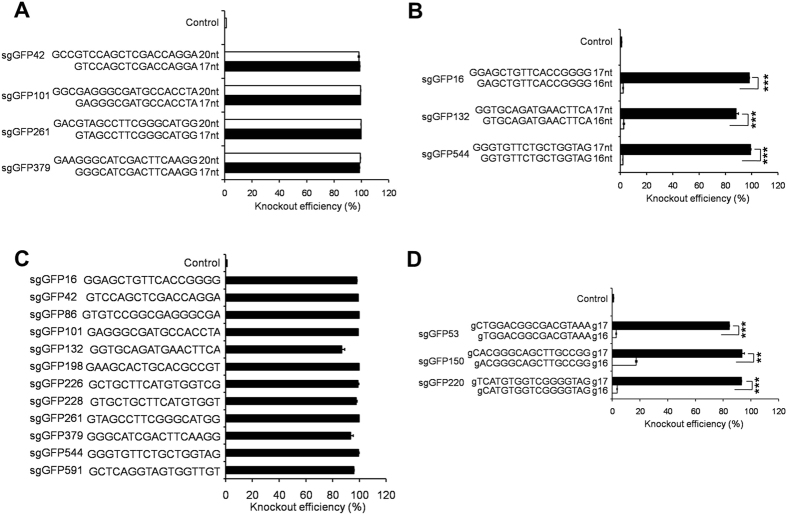
Targeting activities of full-length sgGFPs and truncated sgGFPs in 293T cells.(A) Comparison of GFP knockout efficiency of 17nt vs. 20nt sgGFPs in 293T GFP-reporter cells. Four pairs of sgGFPs were designed to target GFP sites 42, 101, 261 and 379. Lengths and sequences of the sgRNAs are shown. Cells transduced with a scrambled sgRNA served as a control. Data shown are mean ± SEM (n = 3). (B) Comparison of GFP knockout efficiency of 17nt vs. 16nt sgGFPs in 293T GFP-reporter cells. Three pairs of sgGFPs were designed to target GFP sites16, 132, and 544. Lengths and sequences of the sgRNAs are shown. Data shown are mean ± SEM (n = 3). ***P < 0.001. (C) GFP knockout efficiency in 293T GFP-reporter cells with 17nt sgRNAs. Twelve sgGFPs were designed to target different locus of the GFP gene. Data shown are mean ± SEM (n = 3). (D) Comparison of GFP knockout efficiency of gN16 vs. gN17 sgGFPs in 293T GFP-reporter cells. Three pairs of gN16 and gN17 sgGFPs were designed to target GFP sites 53, 150, and 220. Little g indicates mismatched guanine (G). Sequences of the sgRNAs are shown. Data shown are mean ± SEM (n = 3). **P < 0.01; ***P < 0.001.